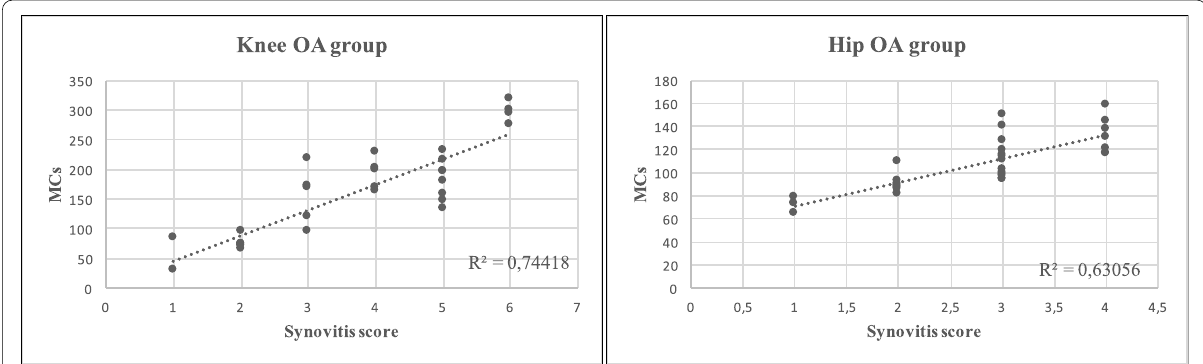
Fig. 1 Correlation of synovitis score and synovial mast cell number in knee and hip tissue from patients with osteoarthritis. R2, Pearson’s correlation coefficient